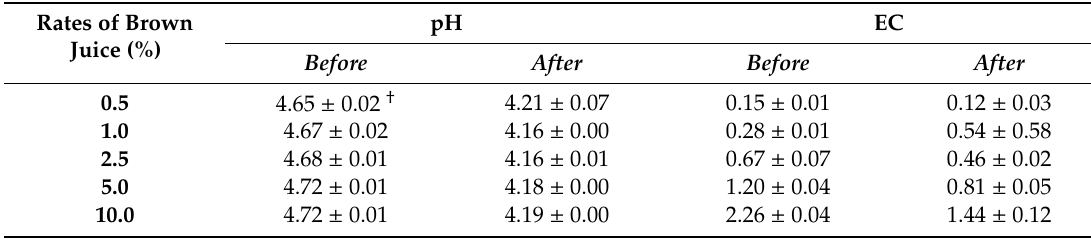
Table 4. pH and electrical conductivity (EC, dS m − 1 ) values of alfalfa brown juice solutions before and after fermentation at the beginning of the